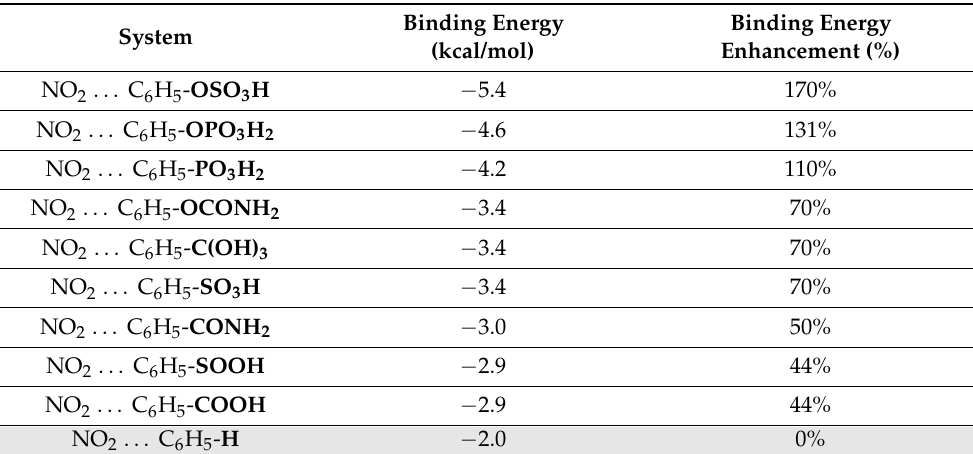
Table 1. Binding energies in kcal/mol of the NO 2 . . . C 6 H 5 -X systems, calculated at the